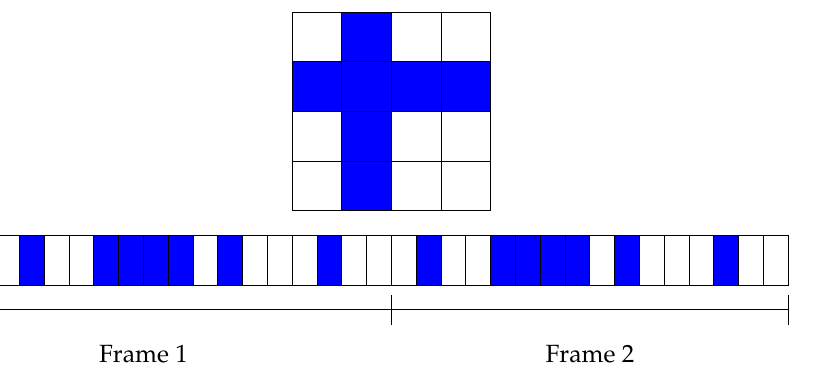
Figure 6. Example of Quorum for m = 4.